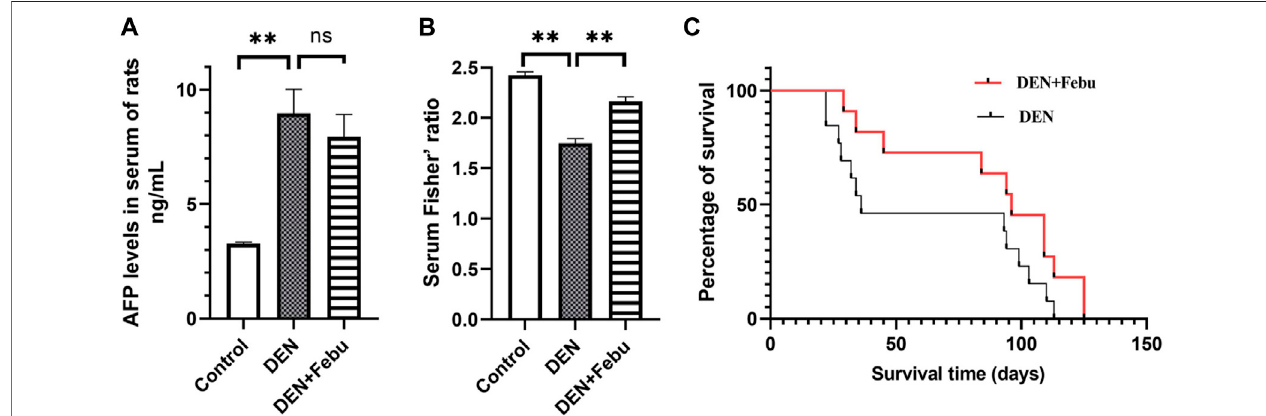
FIGURE 4 | Serum AFP level (A) , Serum Fisher ’ ratio in rats of control (n (cid:1) 5), DEN (n (cid:1) 14) and DEN + Feu ( n (cid:1) 14) group (B) and the survival curve ( C , log-rank Mantel – Coxtest, p (cid:1) 0.0802)ofHCCratsinducedbyDEN( n (cid:1) 15)andthosetreatedbyFebuxostat( n (cid:1) 15).**representsigni fi cantdifferencesbetweengroups(mean ± S.E.M, ** p < 0.01).